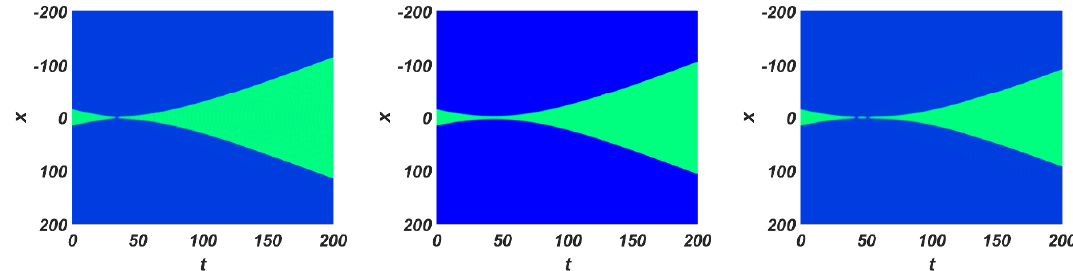
Figure 3 . False vacuum in an unbounded interval: kink-antikink collision for (cid:15) = 0 : 01 with (a) v = 0 : 59, (b) v = 0 : 54 and (c) v = 0 : 558. Compare with diagram of (cid:12)gure 2d. Blue represents the false vacuum (cid:30) = (cid:0) 1 and the true vacuum (cid:30) = +1 is represented in green.